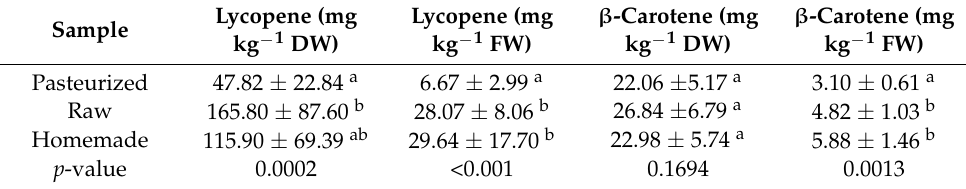
Table 5. Lycopene and β -carotene content (expressed in mg lycopene or β -carotene per g freeze-dried sample or per g fresh weight) of salmorejo samples (mean ±